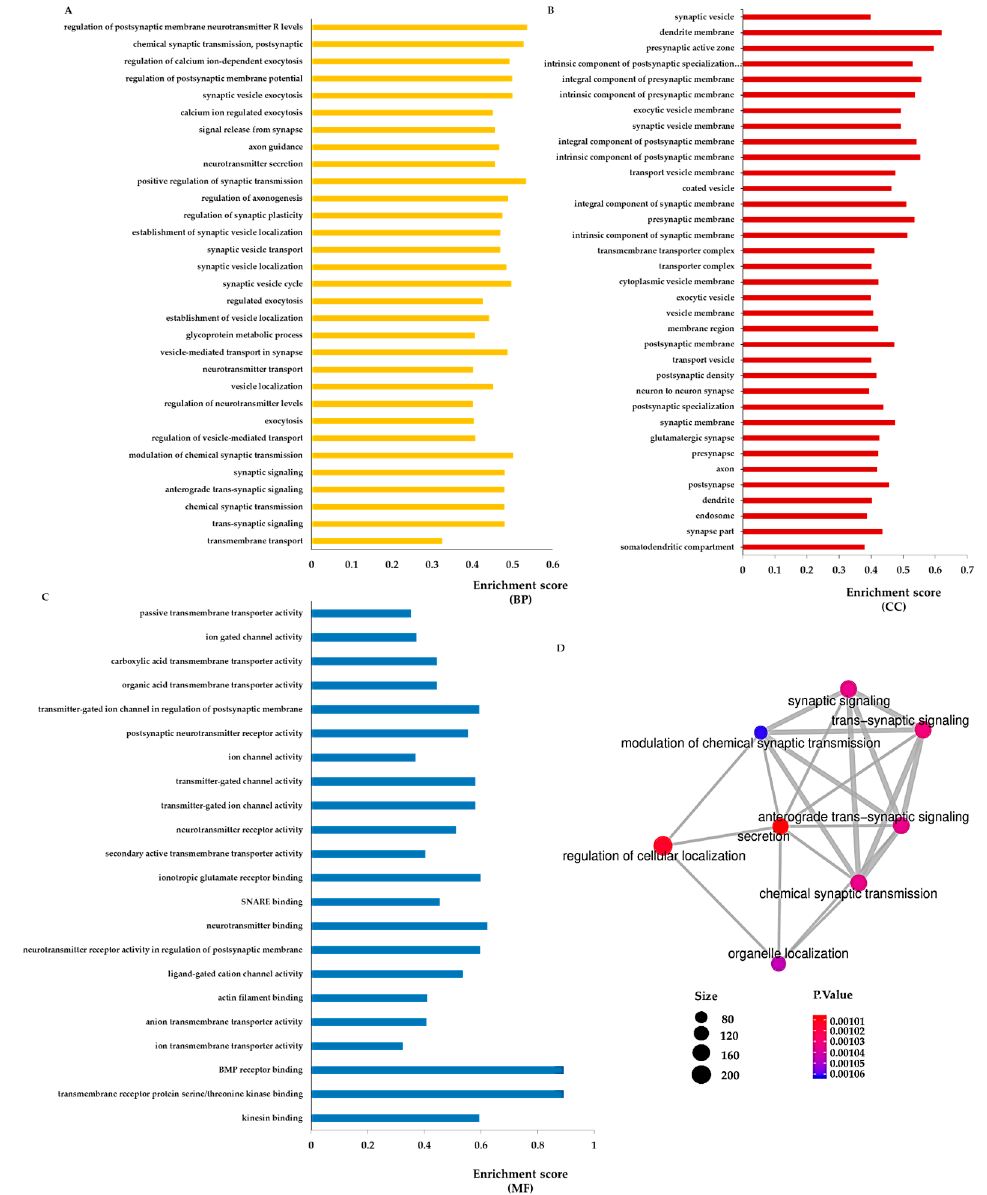
Figure 6. Sitagliptin-enhanced pathways related to synaptic transmission. ( A – C ) Most enriched terms involved in neurotransmission between sitagliptin-treated db/db mice and db/db mice treated with vehicle using the GO database (Biological Process (BP), Cellular Component (CC) and Molecular Function (MF) subcategories, respectively) ( p -value < 0.005). X-axis shows the enrichment score in each category. ( D ) Cluster related to synaptic transmission from the GO enrichment map of the top 60 enriched terms (BP) between db/db sitagliptin and db/db vehicle.